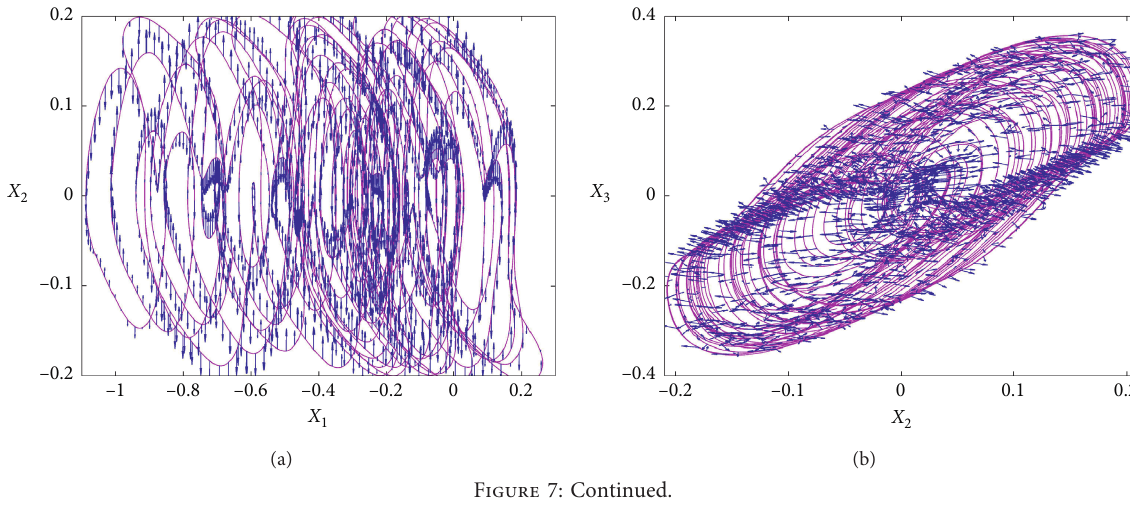
− x plane; (b) 1 2 − x plane. 4 5